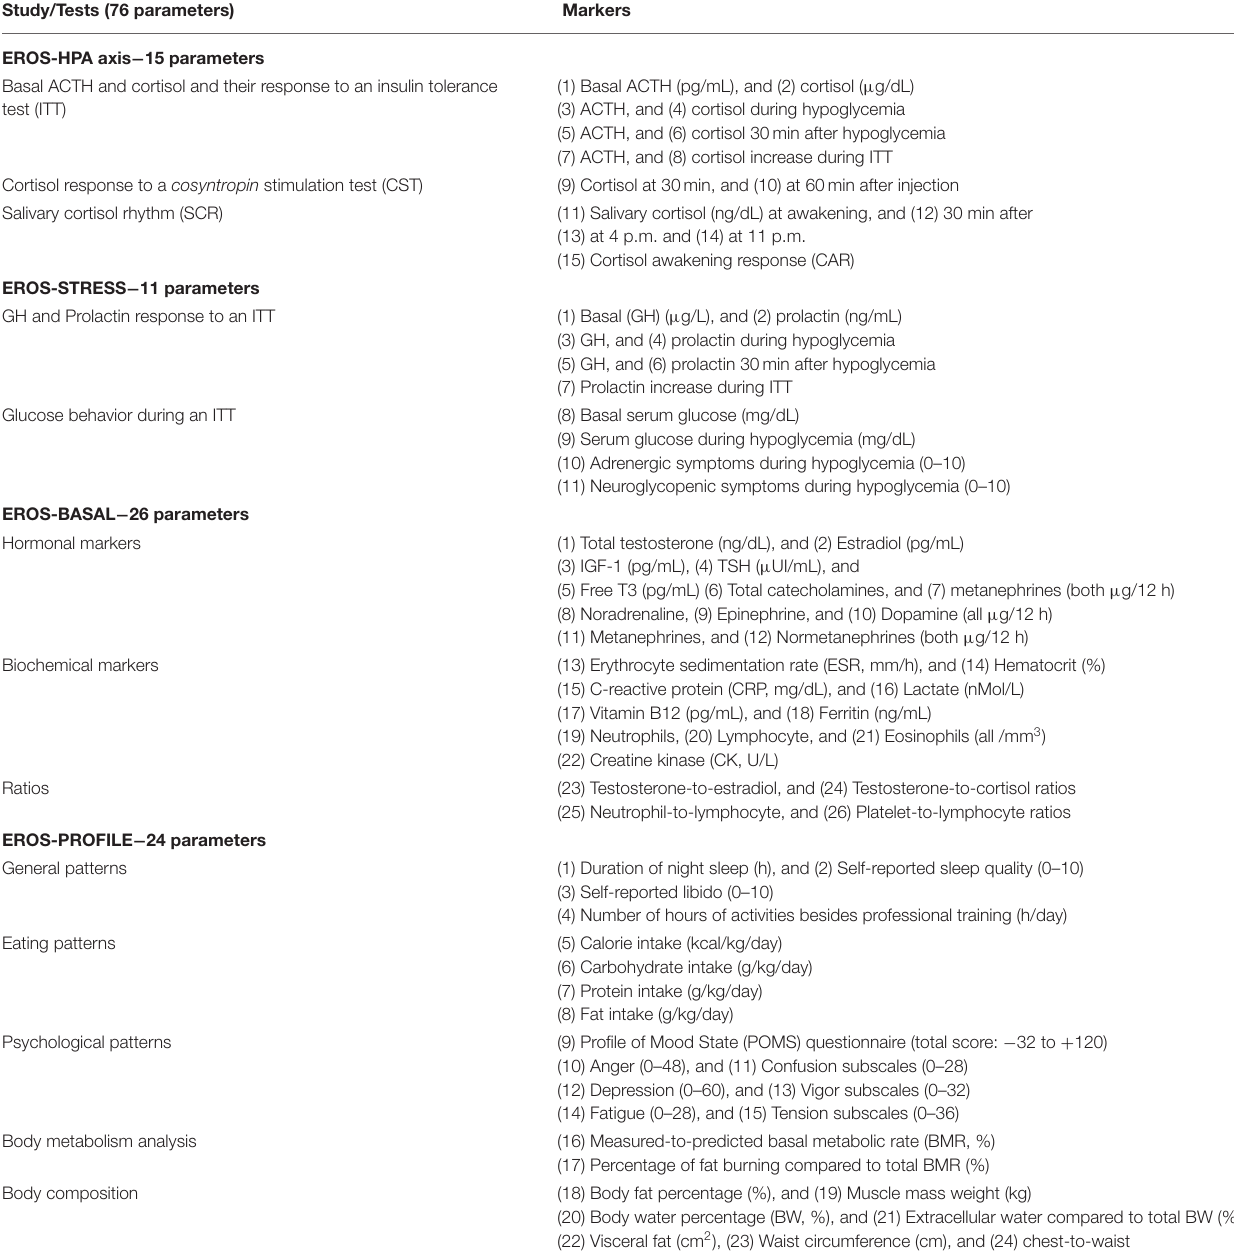
TABLE 1 | Markers evaluated by the EROS study and included in the present